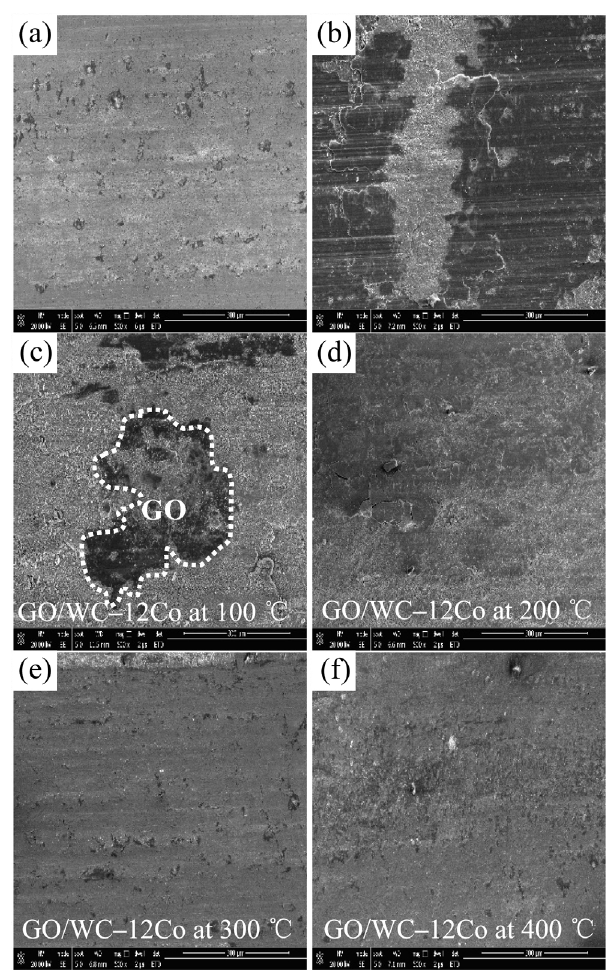
Fig. 13 Macromorphologies of the wear tracks in the coatings after undergoing high-temperature